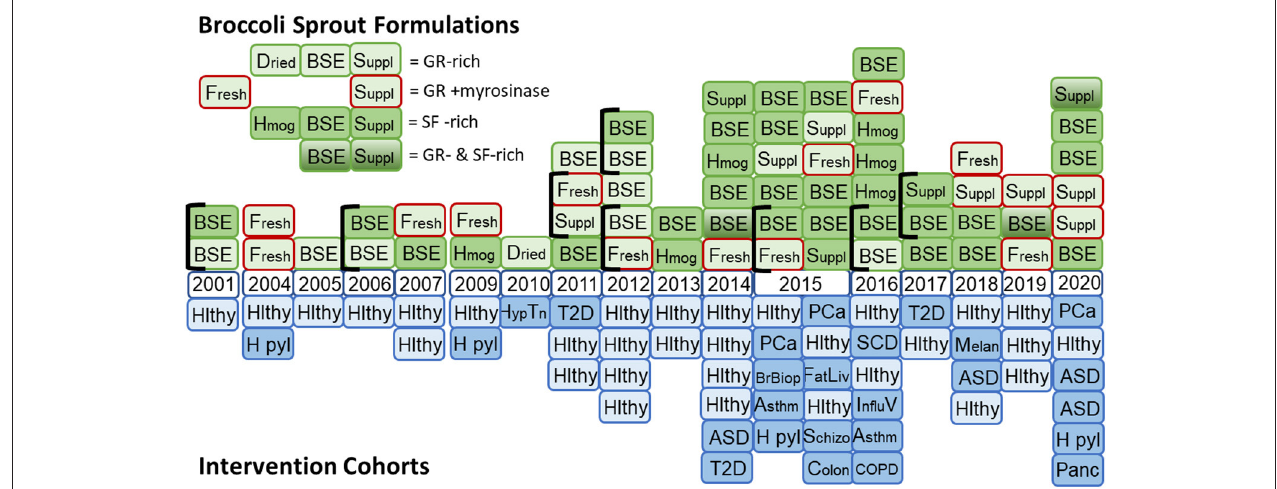
FIGURE 2 | Timeline for the use of formulations of broccoli sprouts in clinical trials. (Top) Glucoraphanin (GR)-rich preparations included dried broccoli sprouts, hot water broccoli sprout extracts (BSE), and supplements formulated with freeze-dried broccoli sprouts or finely milled broccoli seeds to provide GR. Formulations enclosed with a red border included myrosinase (from either broccoli sprouts or daikon sprouts). Sulforaphane (SF)-rich formulations included fresh homogenates of broccoli sprouts, BSE treated with myrosinase or supplements including freeze-dried broccoli sprouts and finely milled broccoli seeds to provide myrosinase and GR. A few studies included blended formulations that included both GR-rich and SF-rich preparations. (Bottom) Mirrored against the study formulations are the study cohorts used with each formulation. Hlthy, healthy volunteers; H pyl, Helicobacter pylori infected participants; Hyp Tn, hypertensive participants; T2D, type 2 diabetes patients; ASD, autism spectrum disorder patients; PCa, prostate cancer patients; BrBiop, patients undergoing breast biospsy; Asthm, patients with asthma; FatLiv, patients with fatty liver; Schizo, schizophrenia patients; Colon, colon cancer patients; SCD, sickle cell disease patients; Influ V, influenza virus infected participants; COPD, chronic obstructive pulmonary disease; Melan, melanoma patients with multiple atypical nevi; Panc, patients with pancreatic